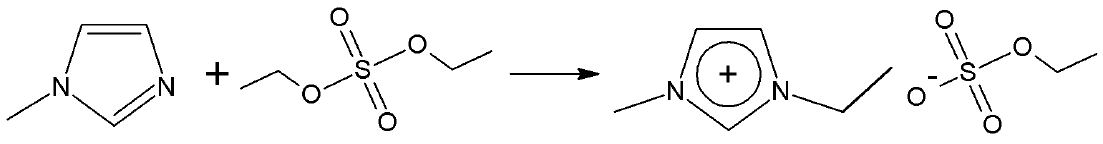
Figure 3. Alkylation of 1-methylimidazol (MIM) with diethyl sulfate (DES)